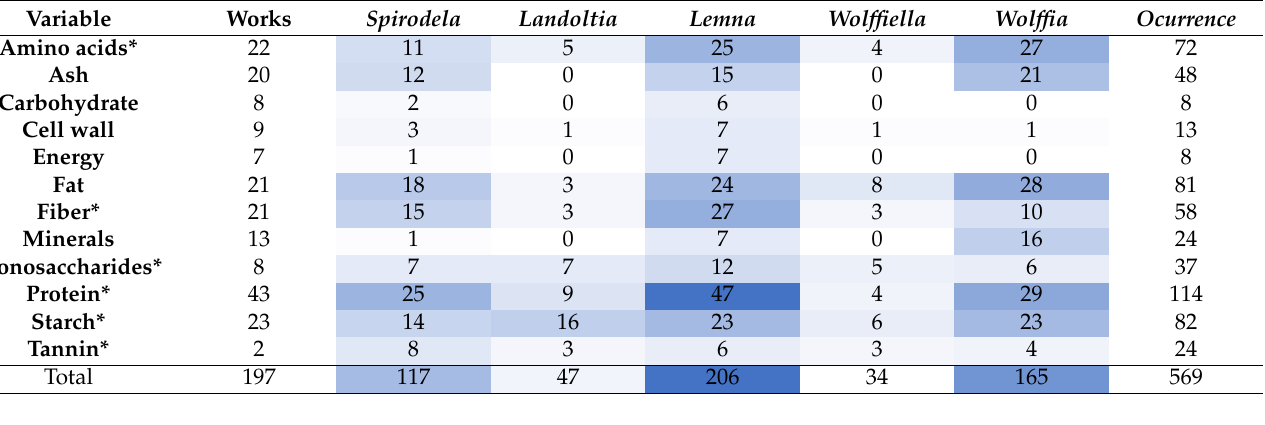
Table 7. Frequency of the recovery data from a systematic review among duckweed genera con- cerning feedstock thematic. Amino acids, ash, carbohydrates, cell wall, energy, fat, fiber, minerals, monosaccharides, protein, starch, and tannin were evaluated. The number of works recovered by the review is shown on the right of the table. The data content of each genus is shown in a box plot which, when the blue is darker, the higher the number of contemplated works. The occurrence refers to the number of entries of the variable. Variables marked with an asterisk (*) have included the data measured during the present